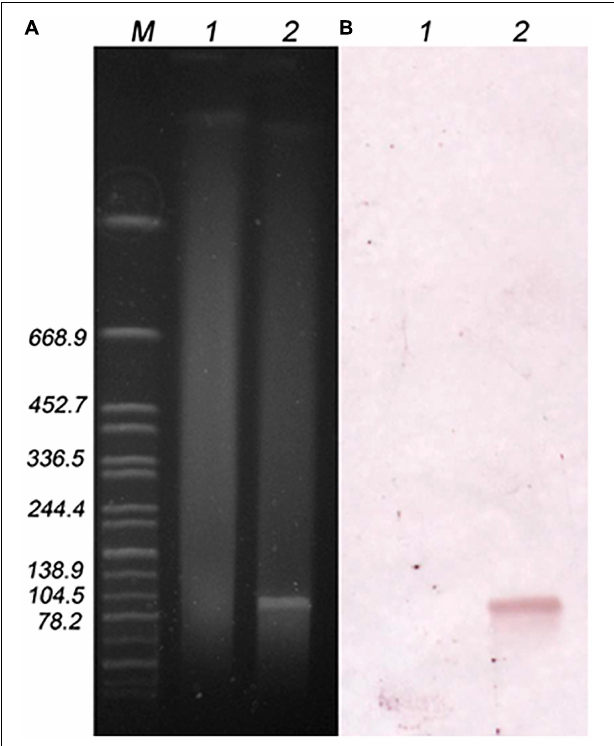
FIGURE 2 | S1 -PFGE plasmid profile of the recipient and transconjugant strains (A) and hybridisation with the lsa (E) probe (B) . M, Global reference strain H9812 of the Salmonella Braenderup serotype digested with the Xba I enzyme; lane 1, recipient strain (R3645); lane 2, transconjugant strain (N7435/R3645).